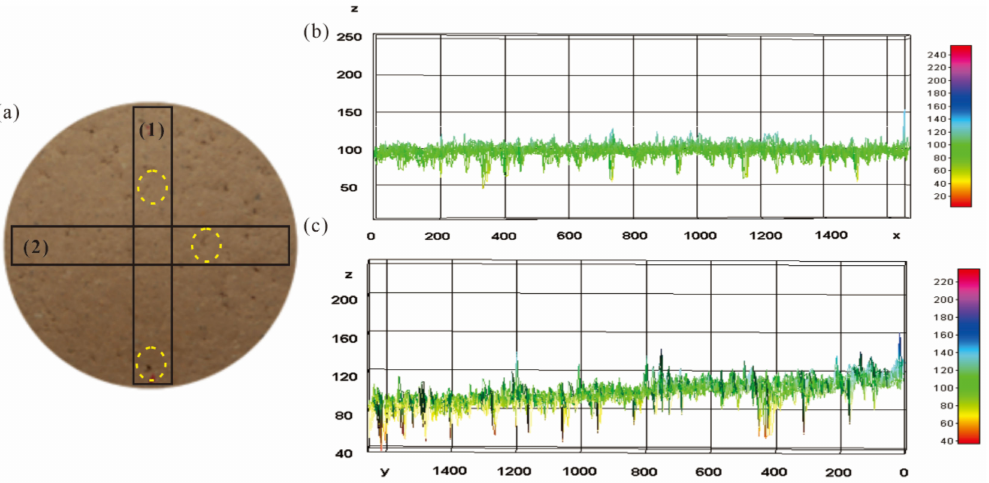
Figure 12. Soil image and color spatial distribution: ( a ) original soil image; ( b ) gray level of rectangle 2; ( c ) gray level of rectangle